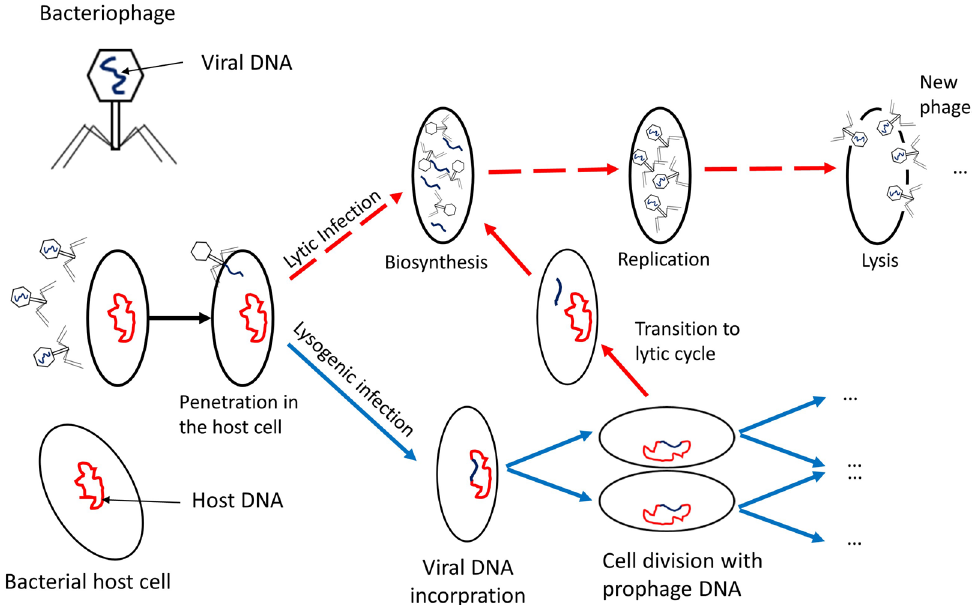
Figure 1. Schematic diagram explaining the two types of infection cycles of the phage (lytic and lysogenic) under the scenario of temperature-dependent lysogeny. At hot temperatures ( T > 35 °C), most phages follow a lytic cycle by killing the pathogen after the infection (shown by red dashed lines). At cooler temperatures ( T < 35 °C), infection by the phage mostly occurs via a lysogenic cycle where bacterial cells become phage- associated (shown by blue lines). However, an increase in the ambient temperature causes the bacteria- associated phages to enter the lytic state and lyse their hosts (shown by the red solid